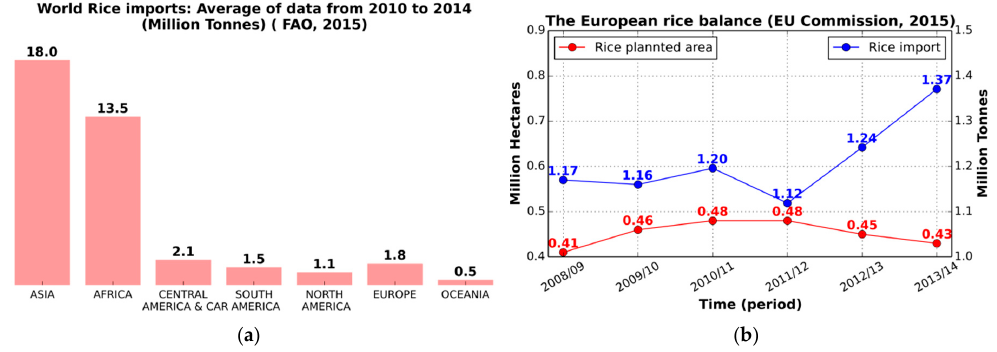
Figure 1. ( a ) Global rice imports, average of data for 2010 to 2014 [1]; and ( b ) the EU rice balance for 2008 to 2013 [37].